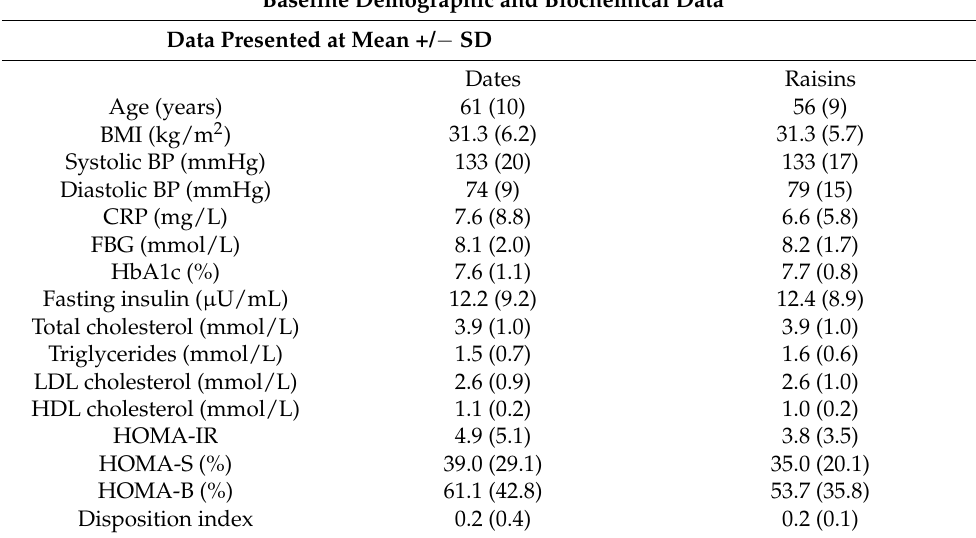
Table 1. Demographic and biochemical data for the date fruit (n = 39) and raisins (n = 40) cohorts at baseline. Data presented as mean +/ − SD. Baseline Demographic and Biochemical Data